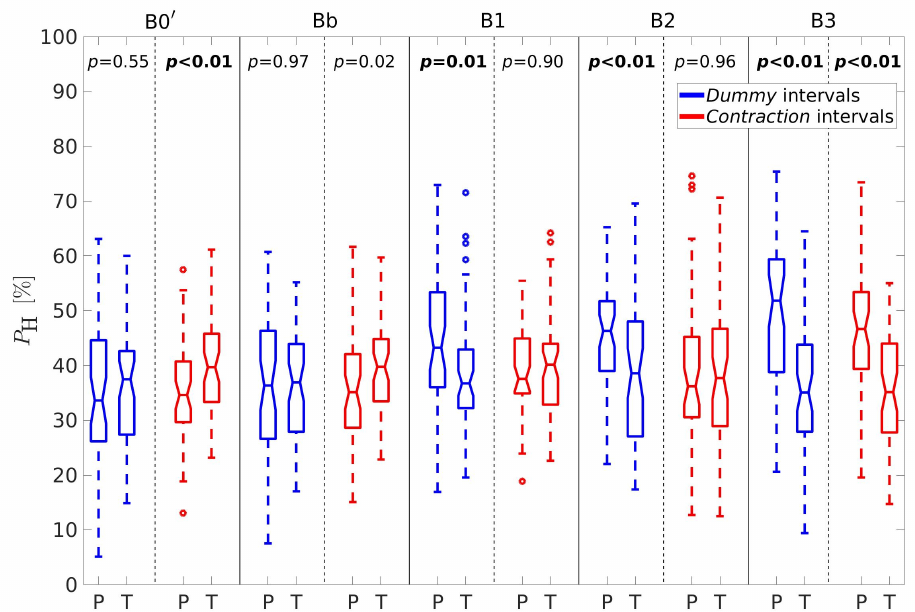
Figure 5. Box plots of the percentages of correlation intervals with velocity vectors in the horizontal direction, P H . P—preterm intervals, T—term intervals.